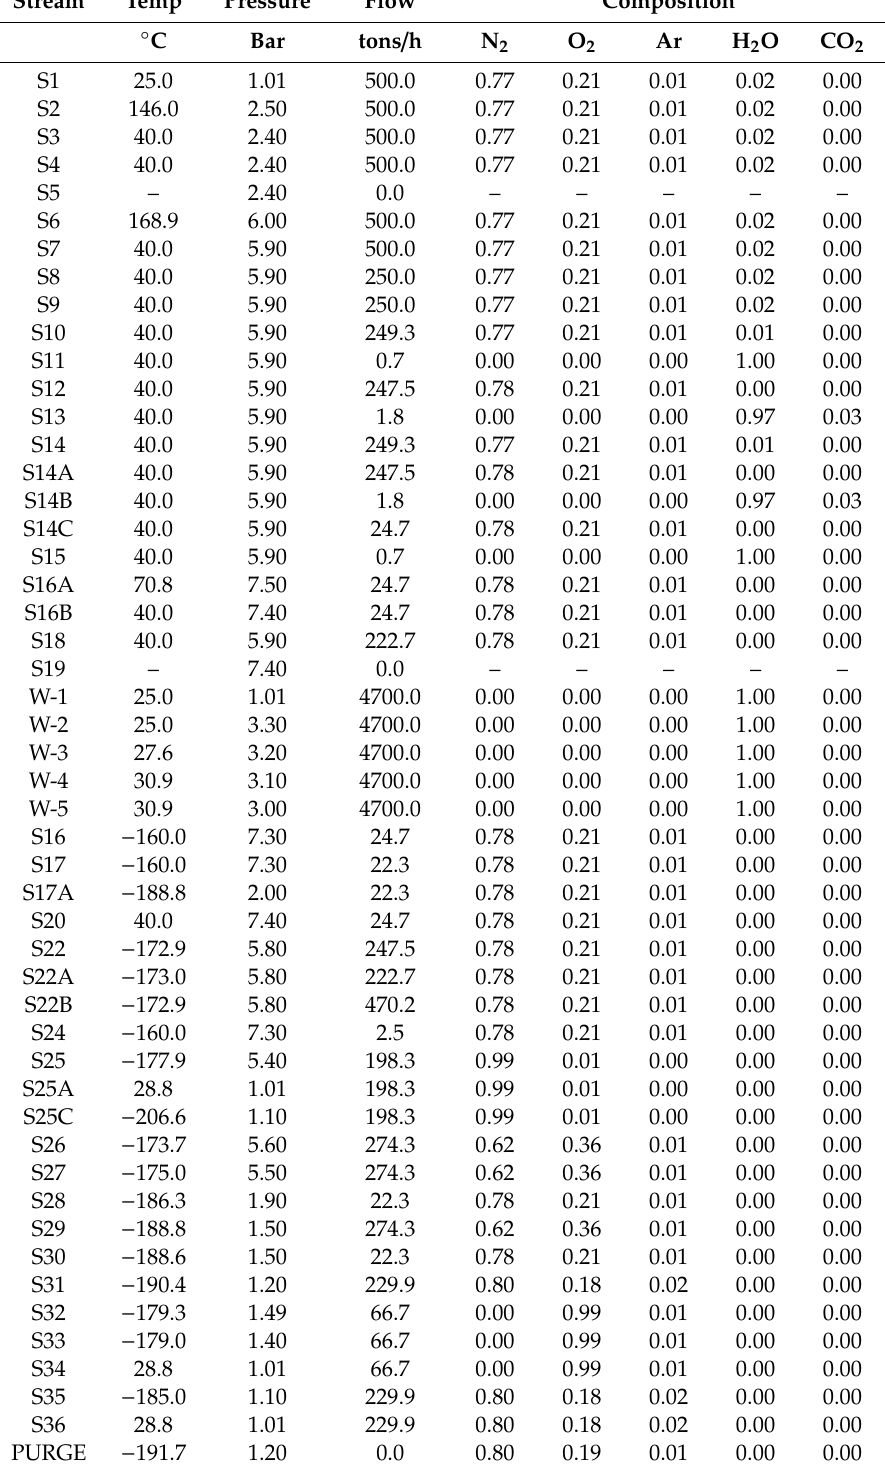
Table 6. Steady-state simulation results for the ASU configuration